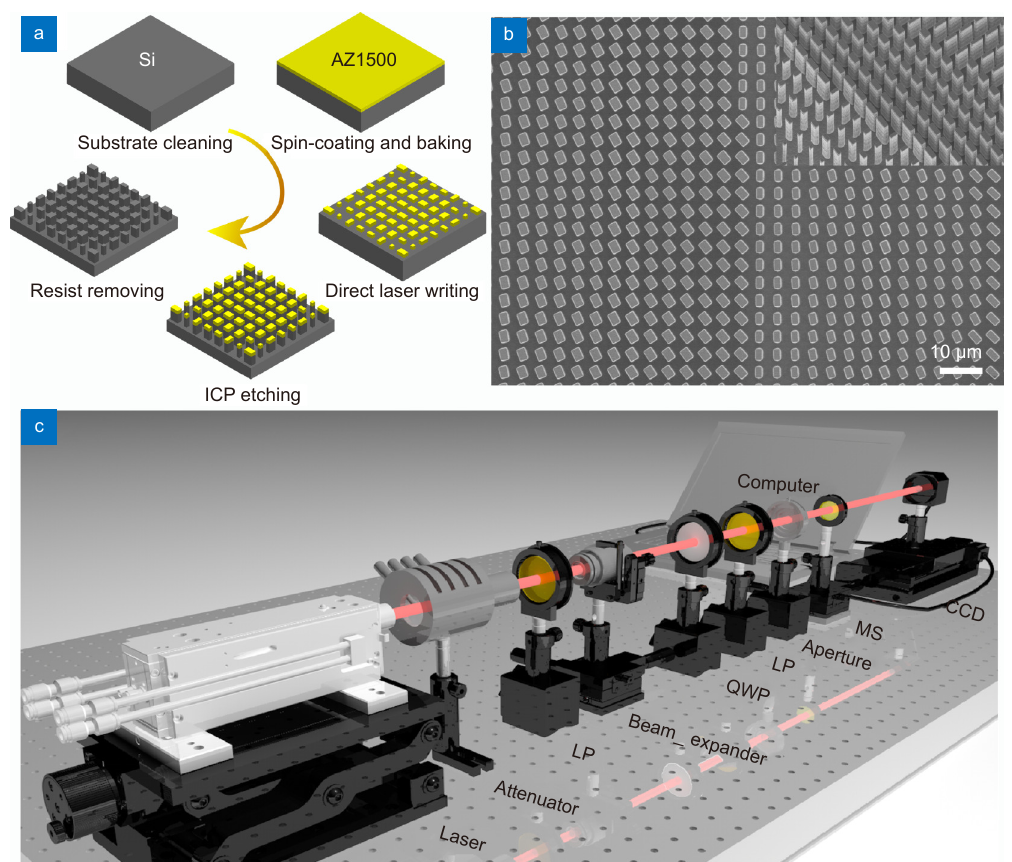
Fig. 4 | Characterization of the polarimeter. ( a ) Schematic diagram of the process of fabricating polarimeter. ( b ) Local SEM image of the polari- meter. The inset is an oblique view of the part of the polarimeter, revealing the high aspect ratio of nanopillars. ( c ) The optical setup for polari- metry. Optical elements: linear polarizer (LP), quarter-wave plate (QWP), metasurface